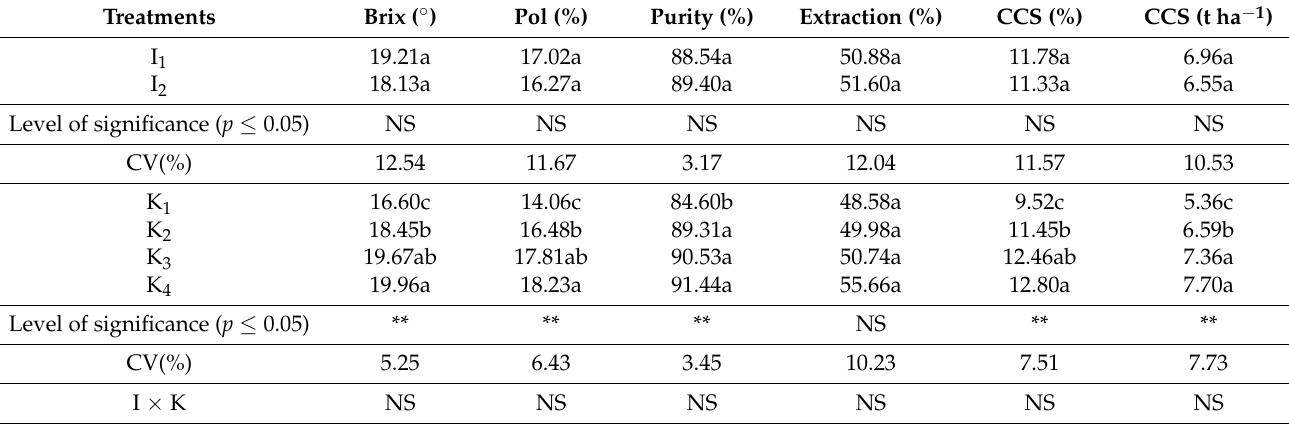
Table 4. Quality parameters of sugarcane 10 months after harvest, at different irrigation and potassium levels. Treatments